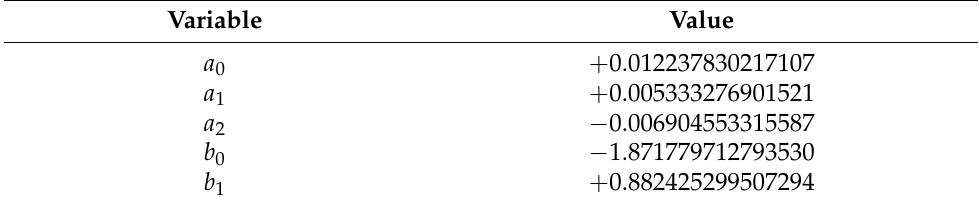
Table A1. Difference in equation constants for the x Cartesian axis.